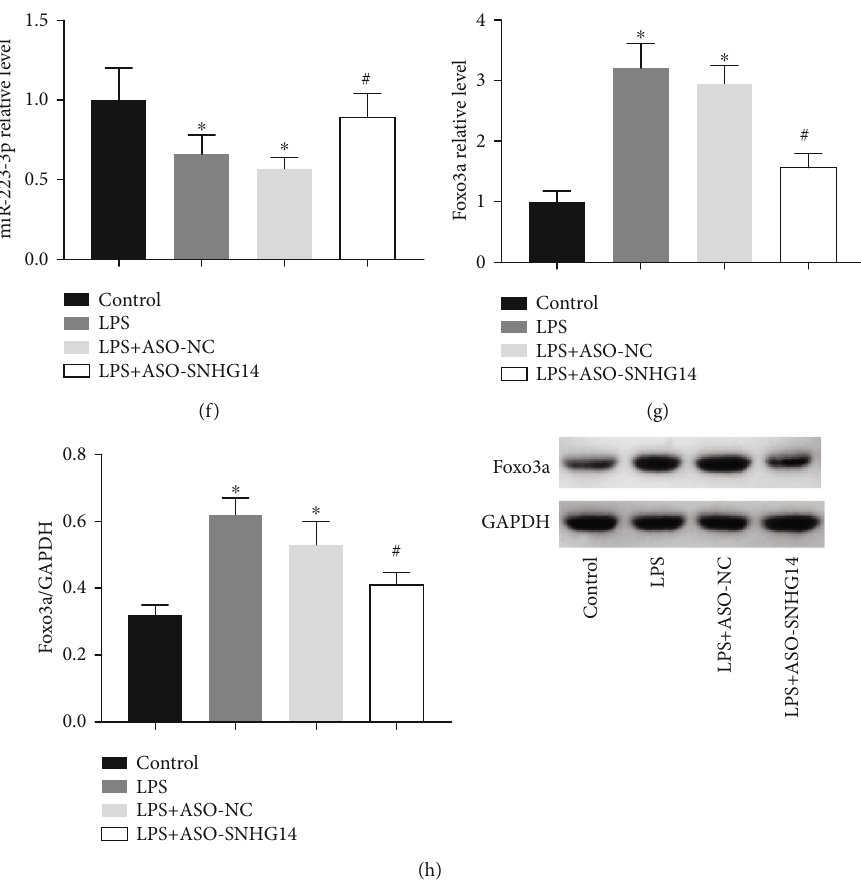
Figure 2: lncRNA-SNHG14 regulated expression of miR-223-3p/Foxo3a in A549 cells. pcDNA3.1-SNHG14 and ASO-SNHG14 were transfected into A549 cells. After 48 h, miR-223-3p (a), Foxo3a mRNA (b), and Foxo3a protein (c) by qRT-PCR and western blot. miR- 223-3p was transfected or cotransfected with pcDNA3.1-SNHG14, Foxo3a mRNA (d), and Foxo3a protein (e) were detected by qRT- PCR and western blot. ASO-SNHG14 was transfected into cells 24 h ahead of LPS treatment. Under LPS treating condition, miR-223-3p (f), Foxo3a mRNA (g), and Foxo3a protein (h) were detected. ∗ P < 0 : 05 compared with transfection negative control or LPS untreated control. # P < 0 : 05 compared with miR-223-3p mimic+pcDNA3.1 or